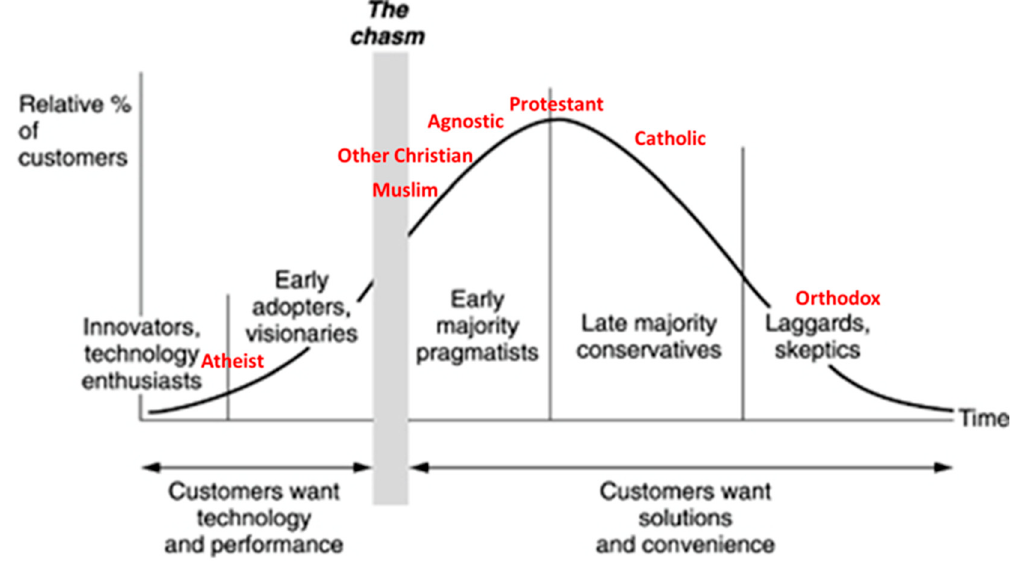
Figure 5. Life cycle and religions in Europe. Source: own elaboration based on Norman (1998).